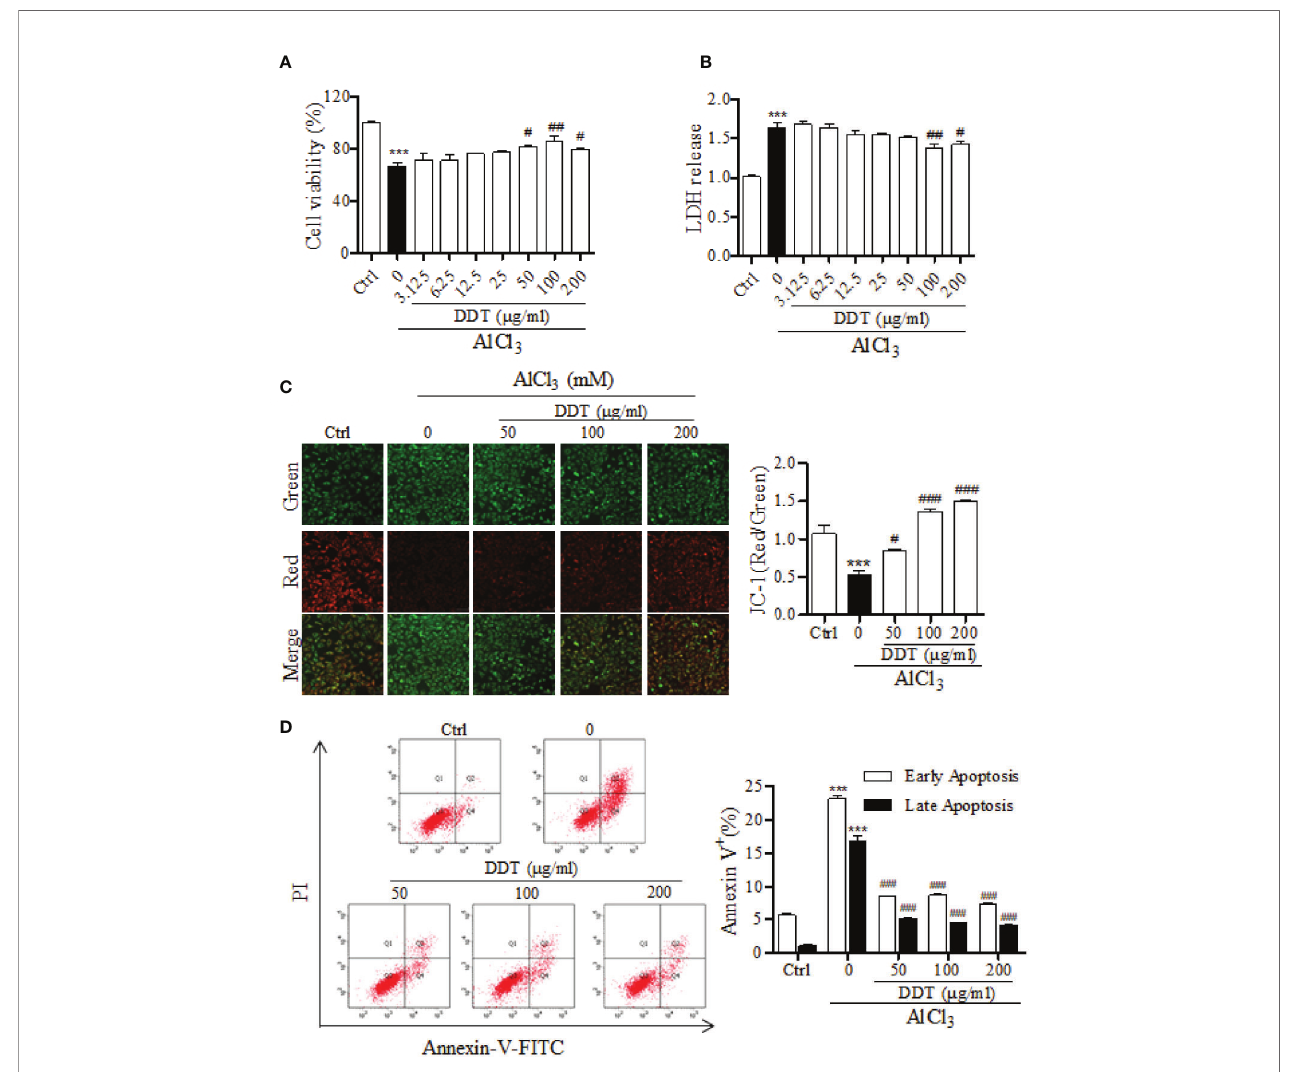
FIGURE 3 | DDT protects PC12 cells from damage and apoptosis induced by AlCl 3 . (A) After treatment with DDT and/or AlCl 3 for 48 h, PC12 cell viability was assessed by an MTT assay. (B) LDH release was measured in PC12 cells treated with AlCl 3 , DDT-treated, or both for 48 h using an LDH assay kit. (C) Following treatment with DDT and/or AlCl 3 for 48 h, PC12 cells were incubated with a JC-1 probe to measure mitochondrial membrane potential. The bar graph on the right represents the fl uorescent intensity of JC-1. (D) Cells treated with DDT, AlCl 3 , or both were stained with Annexin V and PI, and then were analyzed by fl ow cytometry. Data are expressed as the average percentages of cells in early and late apoptosis. Values are means ± standard derivation from three independent experiments. Ctrl: control group. *** p < 0.001 vs. control group; # p < 0.05, ## p < 0.01, ### p < 0.001 vs. AlCl 3 -induced model